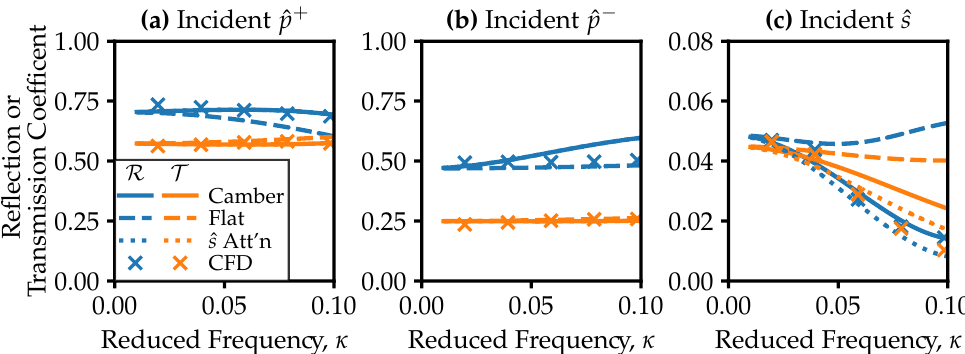
Figure 4. Reflection and transmission coefficients for an uncooled vane cascade, predicted by analytical model and CFD, for different incident characteristic waves. ˆ s Att’n denotes augmentation with Bauerheim et al. [4] streamtube model. The cambered model matches the CFD results to within on average 2% for downstream-running pressure wave reflection, and ± reflection, an improvement over flat